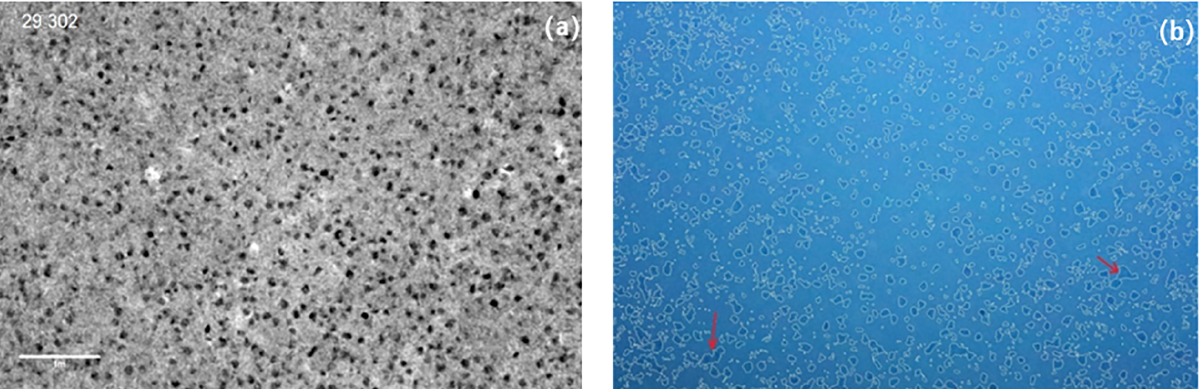
Figure A6. Example for how the program identifies nodules in the image. (a) The greyscale image provides higher contrasts for better nodule identification. (b) Image showing boundaries of the nodules the program has set for each recognized nodule. Red arrows indicate examples for locations where several nodules are bound together, which leads to larger values in the size calculation. The white scale bar in sub-figure a corresponds to